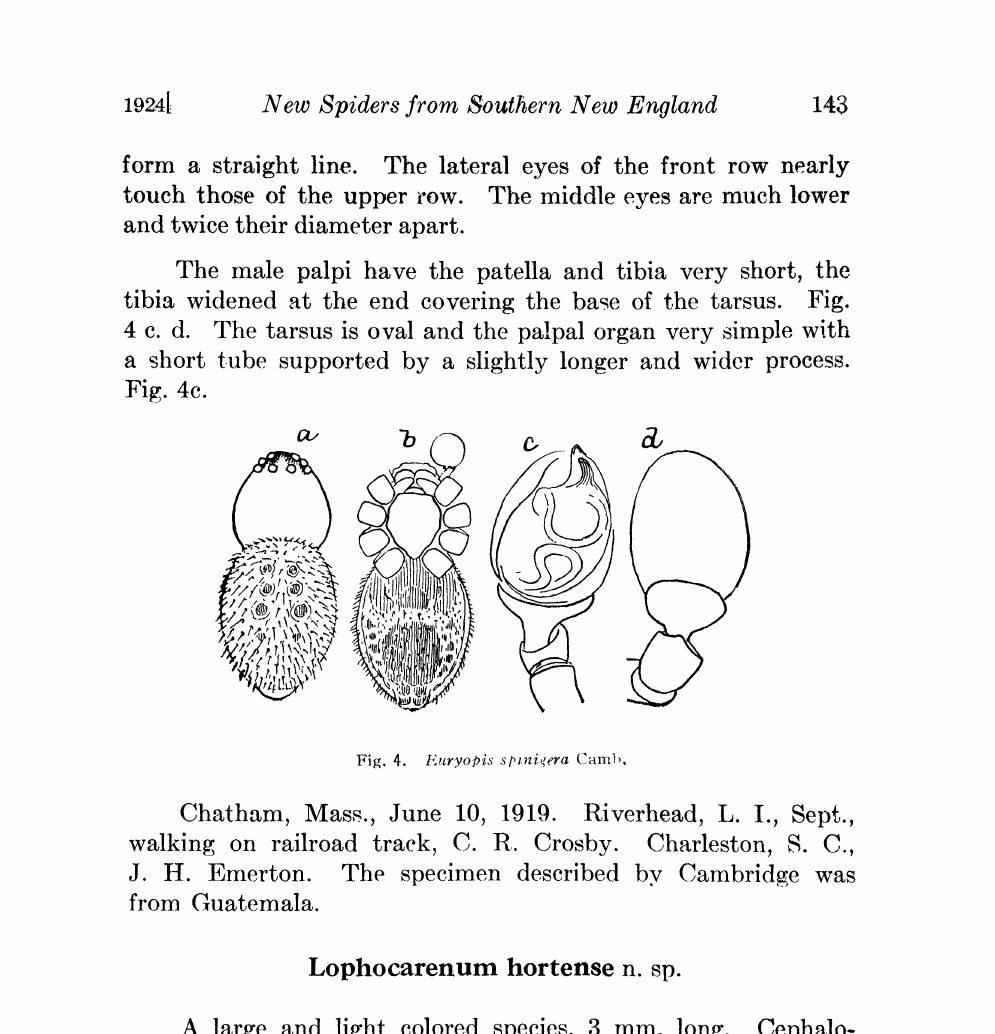
Fig. 4. I2uro#is sp,ni,;era